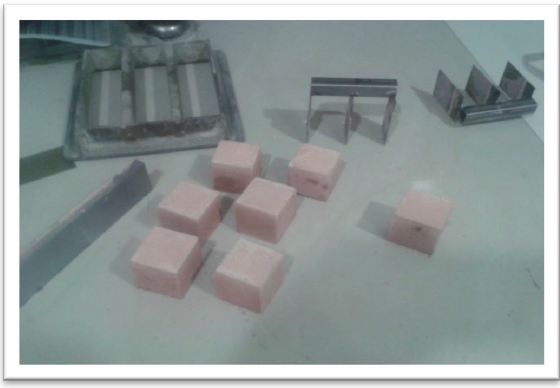
Figure 2. Photograph of 4×4×4 cm 3 clay mortar cubes prepared by mixing the clayey soil Figure 2: Photograph of 4´4´4 cm 3 clay mortar cubes prepared by thermally treated at 850 o C for three hours, lime and standard sand. mixing the clayey soil thermally treated at 850°C for 3 hours, lime and standard